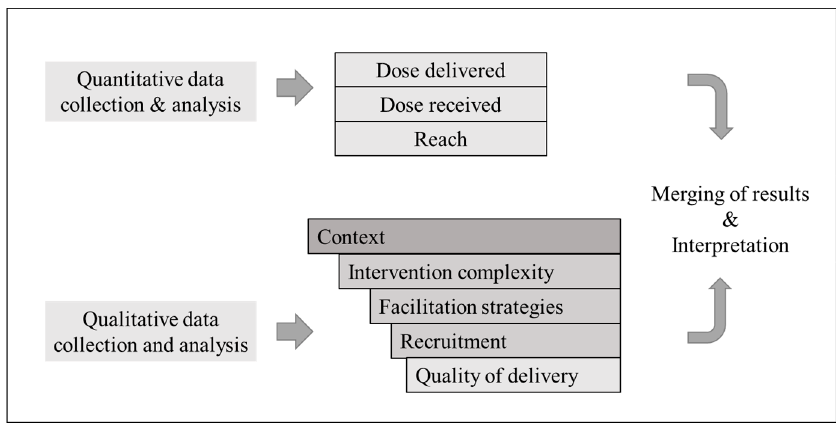
Figure 1. Framework of the elements for the school-based program process evaluation using mixed Figure 1. methods.